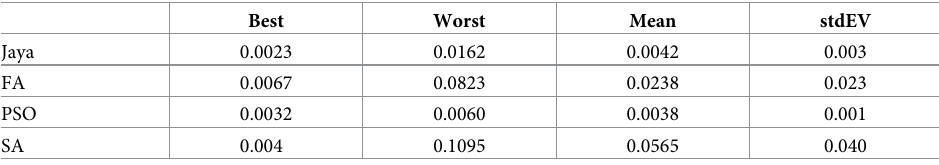
parameters are set as [38]. For FA, α = 1.0, β = 1.0, γ = 0.01, θ = 0.97. Each algorithm is run 15 0 times. In Table 5, Mean, best, worst, and stdEV are average, best, worst, and standard deviation of 15 runs. The results conducted by the Jaya algorithm are better than the others. Table 5. The comparison results of FA, PSO, SA and Jaya